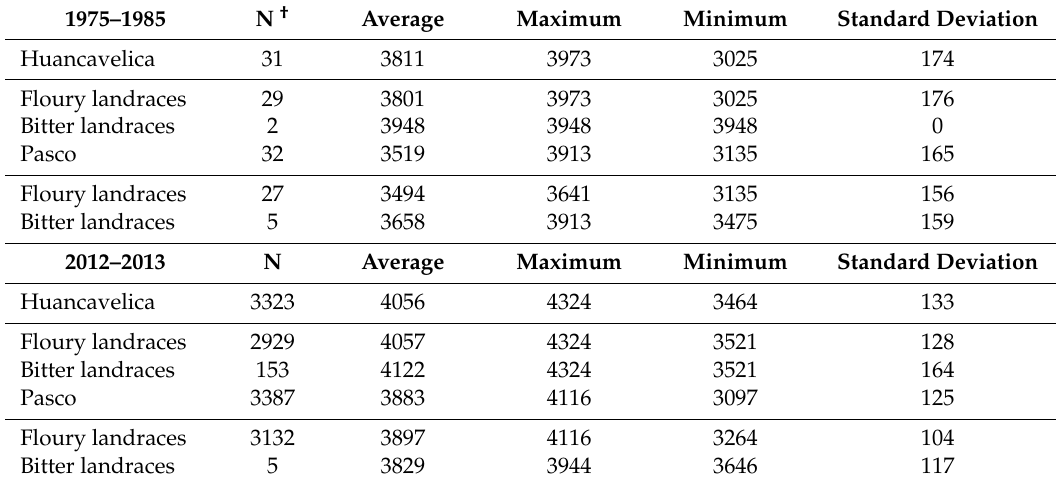
† Number of reference cultivar